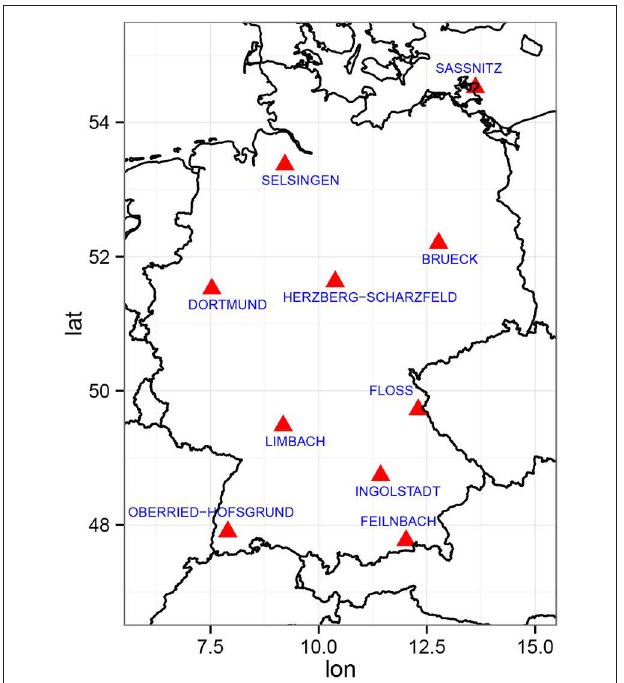
FIGURE 5 | Location and names of the 10 example